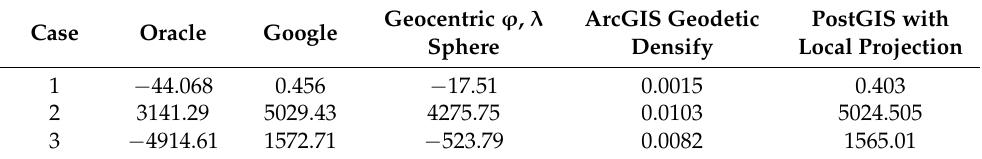
Table 7. Minimum distance deviation by the different products and methods, values in